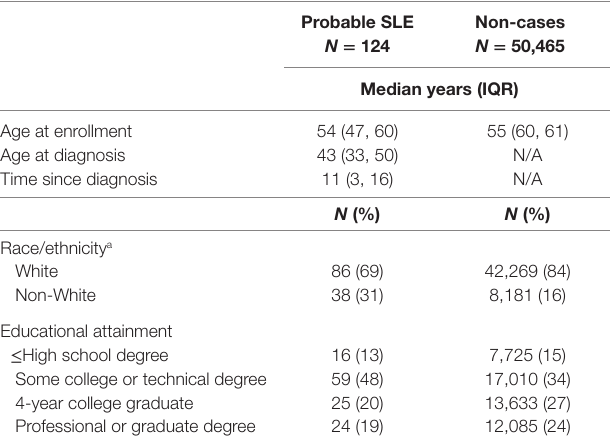
TaBle 1 | characteristics of probable sle cases and non-cases in the sister study.